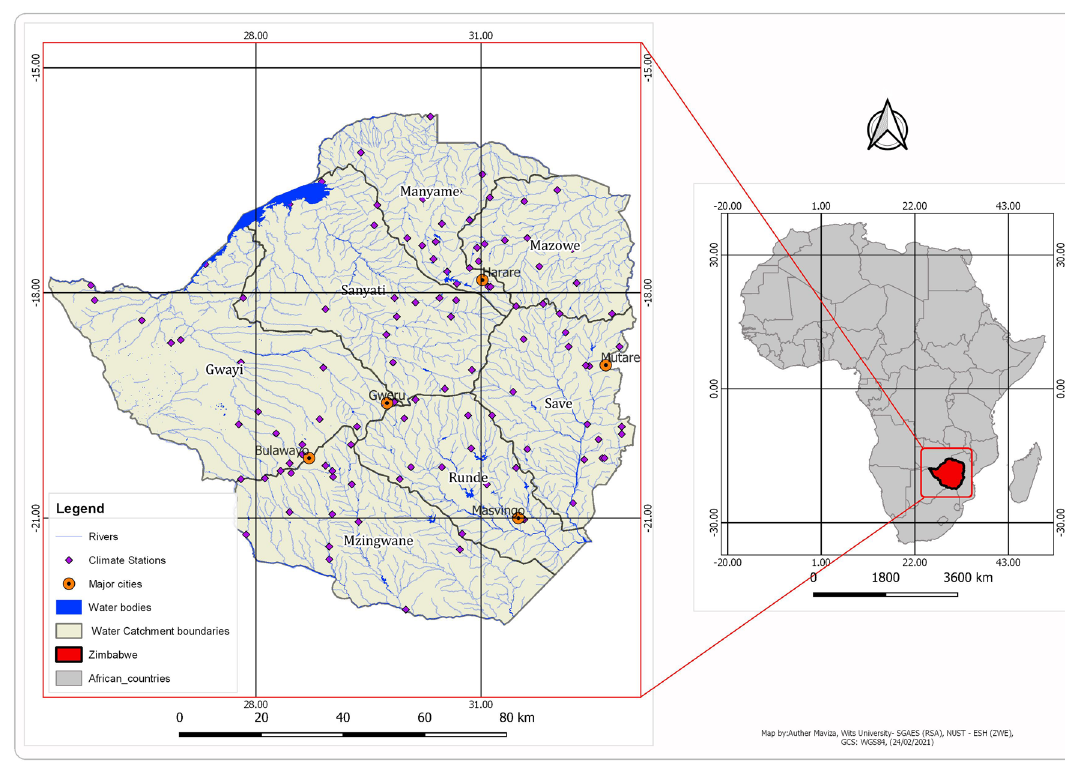
Fig. 2 Map showing location of Zimbabwe (study area) relative to other countries in